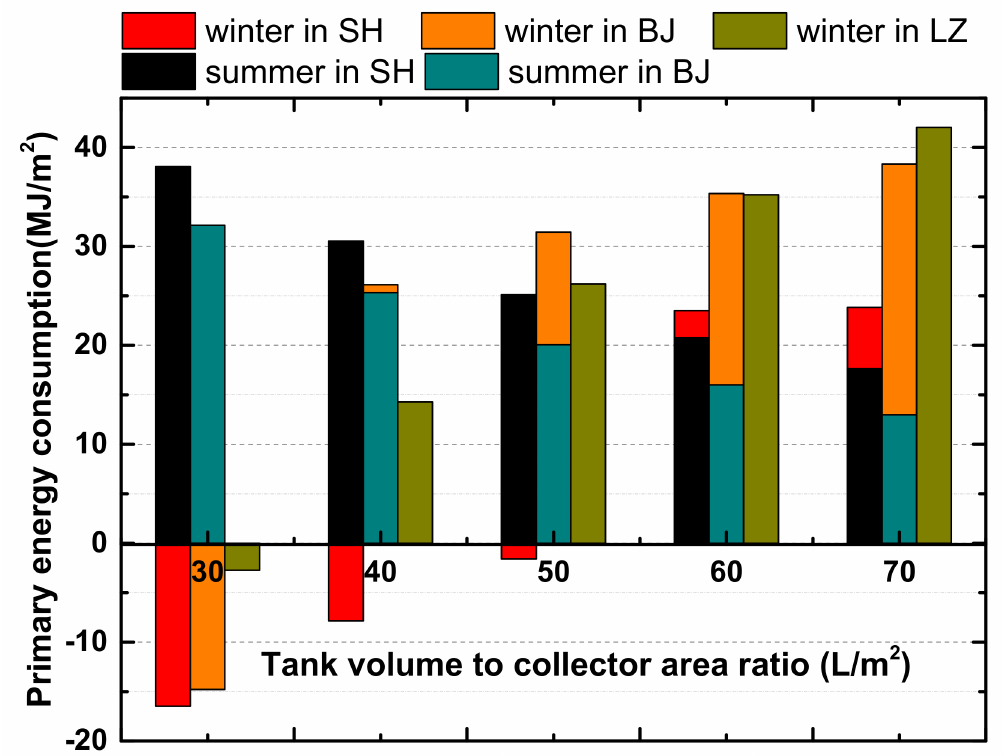
Figure 13. Primary energy consumption under different tank volume to collector area